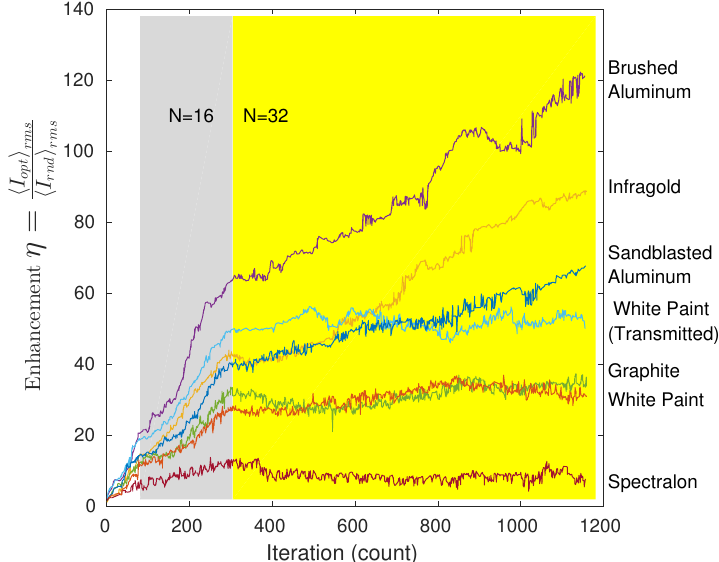
Figure 6. The smaller optimized segments in the N = 32 case produced no improvement compared to the N = 16 case for the graphite and Spectralon R (cid:13) reflectors. The enhancement for the white paint reflector continued to increase slowly during the initial segment optimization of the N = 32 stage, but began to decrease midway through the optimization process. At the completion of the N = 32 stage, the enhancement for the white paint reflector is only slightly higher than the N = 16 enhancement.